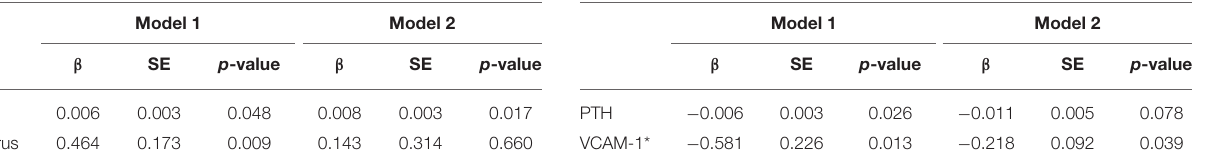
TABLE 5 | Associations of PTH and VCAM-1 with Acetylcholine-induced iontophoresis * (ratio of response to baseline) by multiple linear regression